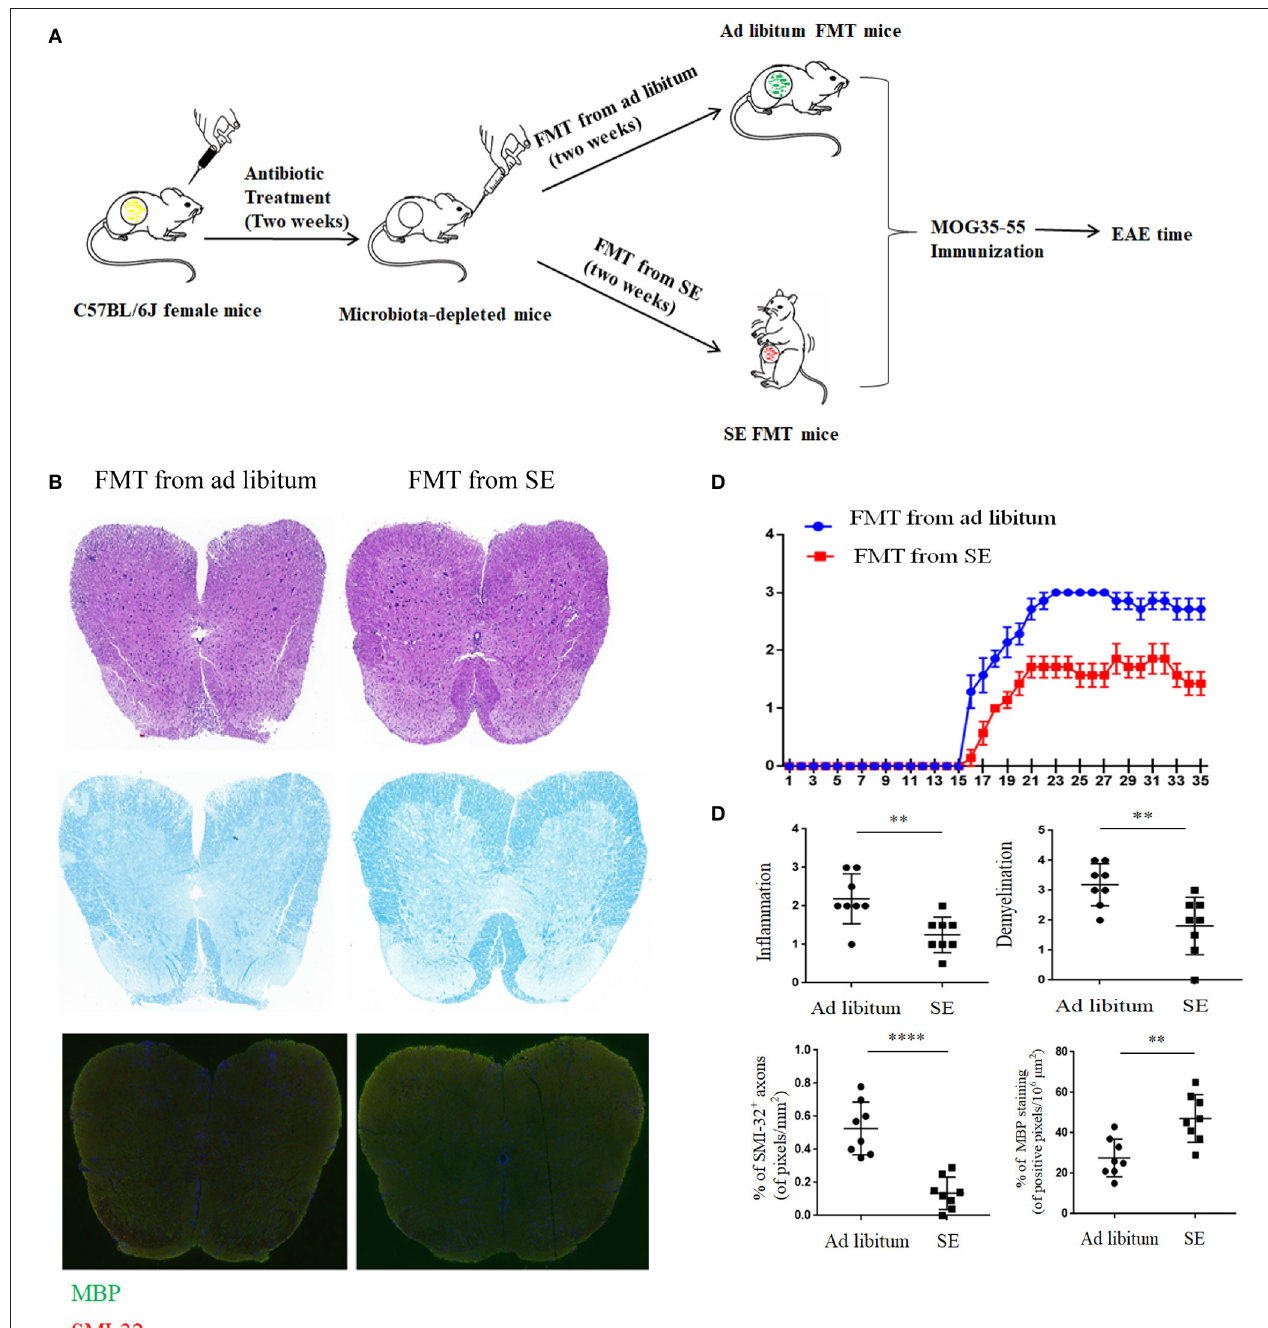
FIGURE 6 | Fecal microbiota transplantation from mice on strength exercise confer protection in experimental autoimmune encephalomyelitis Mice were pretreated with an antibiotic cocktail for 2 weeks and then subjected to FMT from ad libitum or SE for 2 weeks before EAE induced. At least two independent EAE experiments were performed with similar results. (A) The workflow diagram for FMT study. (B) Histopathology assessment ( n = 8): at 21 days post-immunization, lumbosacral spinal cords were isolated and performed H&E staining, Luxol fast blue staining or immunostaining for SMI-32 + damaged axons (in red) and myelin basic protein (MBP; in green). Scale bars, 200 µ m. (C) EAE clinical score of a representative experiment was assessed daily and shown ( n = 9). p < 0.0001 by two-way ANOVA. (D) Quantification of inflammation, demyelination, MBP staining, and axonal damage (evaluated by SMI-32 + staining) in the lumbosacral spinal cords in the two FMT groups. Each dot represents a mouse, and the bars are means ± SD. ** p < 0.01, **** p < 0.001.